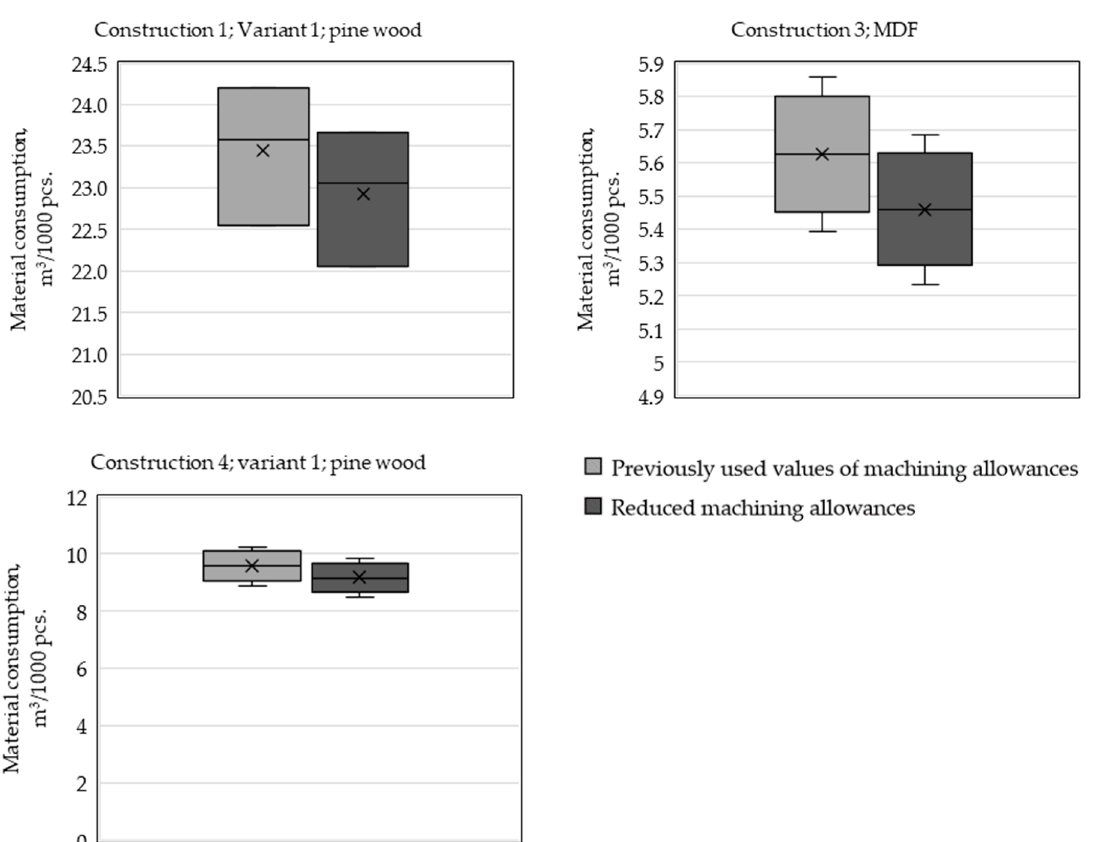
Figure 11. Box plots of median values of material consumption.